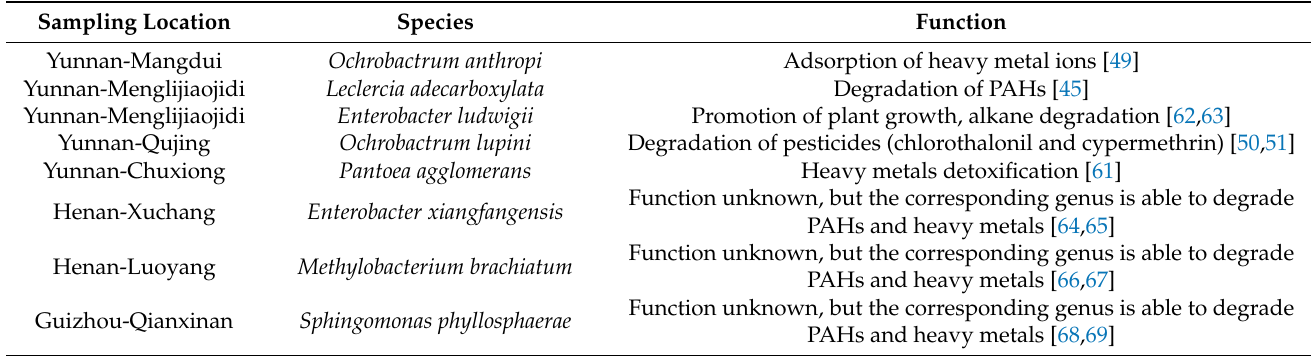
Table 2. The significantly different species among the